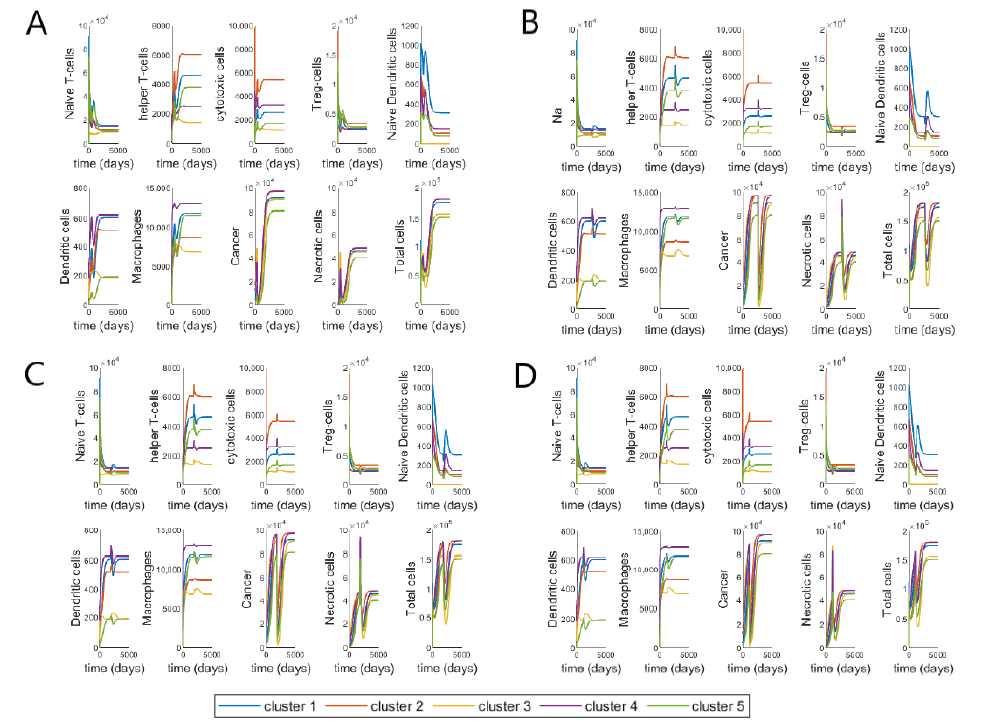
Figure 5. Varying treatment start-time. In the corresponding ( A – D ), the treatment is given after 1, 3, 5 and 7 years respectively. Seven years is the approximate time for the cancer to reach the steady